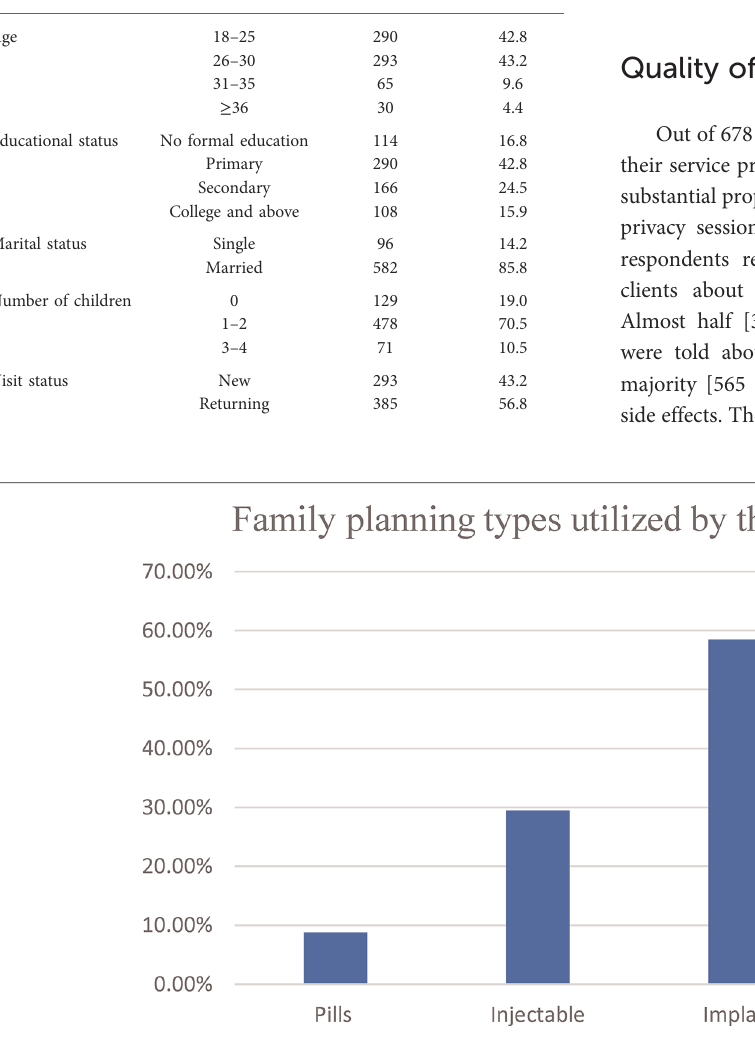
FIGURE 1 Types of family planning utilized among women attending family planning clinics at health centers in Akaki Kality sub-city, Addis Ababa, Ethiopia, 2020 ( N